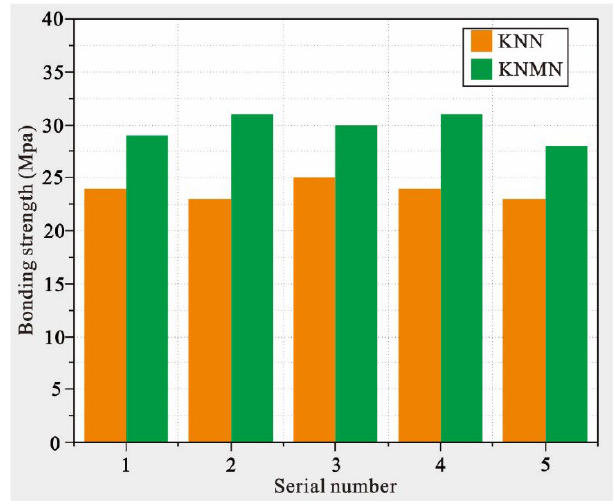
Figure 10. Bond strength of KNN and KNMN coatings.